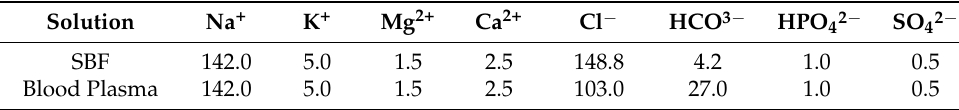
Table 5. Ion concentration of SBF and blood plasma (mol/L).